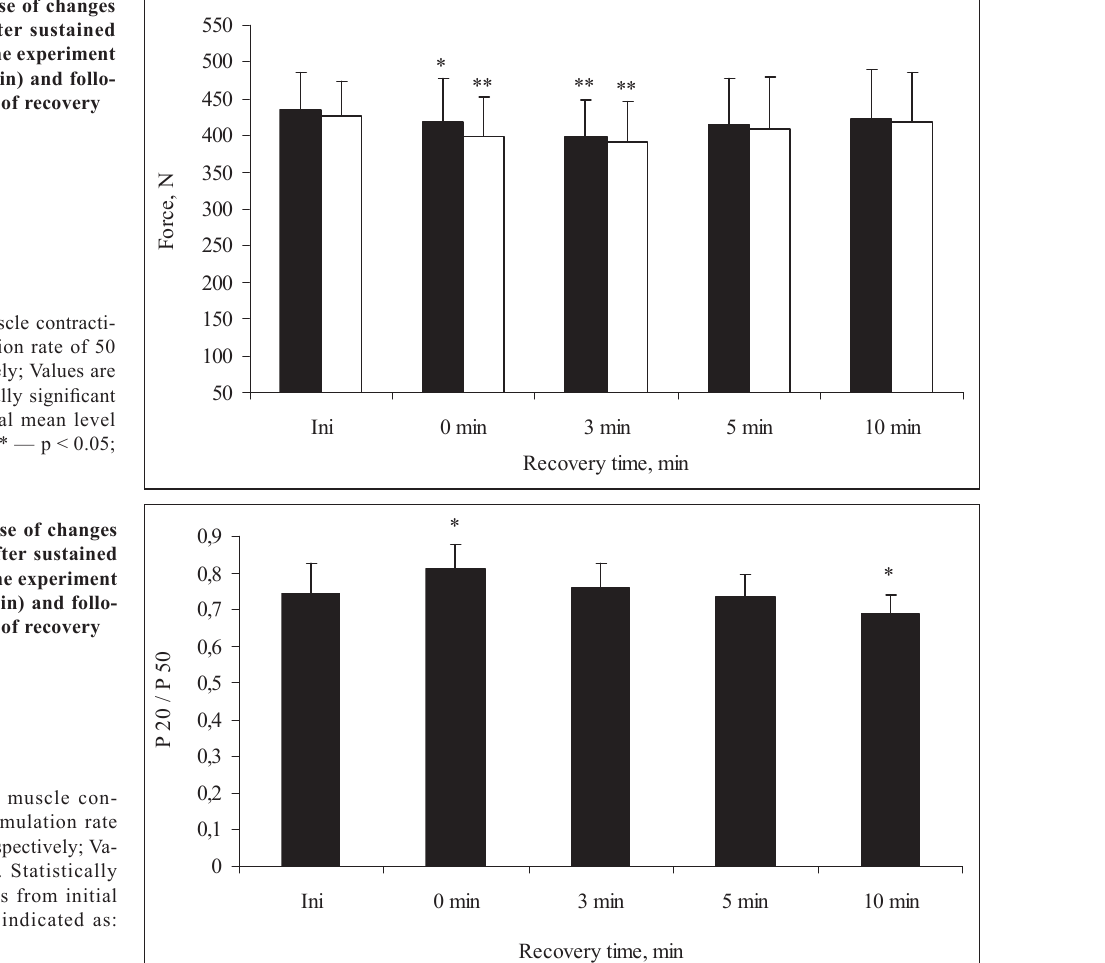
Fig. 3. The time-course of changes in P 50 and P 100 after sustained MVC for 5 s before the experiment (Ini), right after (0 min) and follo- wing 3, 5 and 10 min of recovery